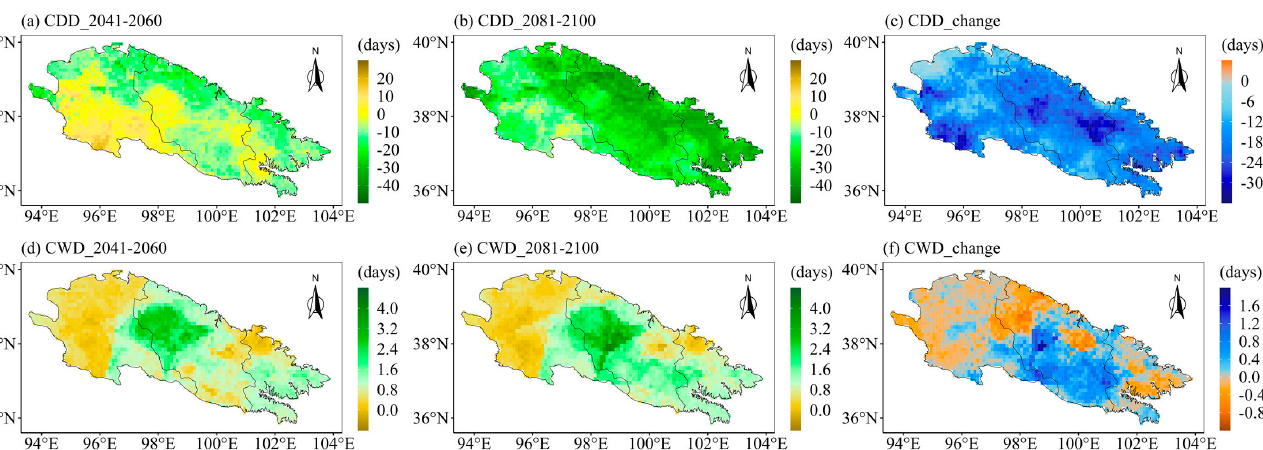
Figure 12. ( left ) The changes of extreme precipitation indices in the middle of the 21st century as compared to the base period, ( middle ) the changes of extreme precipitation indices at the end of the 21st century as compared to the base period, and ( right ) the changes of extreme precipitation indices at the end of the 21st century as compared to the middle of the 21st century. Spatial distri- bution over the Qilian Mountains under SSP585: ( a – c ) CDD, ( d – f ) CWD, ( g – i ) R10mm, and ( j – l ) R95p. Note that the future change is represented by the ensemble of the corrected CMIP6 models. 4.3. Inter-Annual Variations of the Future Extreme Precipitation Indices The Qilian Mountains are the source of many inland river basins in western China, such as the Heihe basin, Shiyanghe basin, Shulehe basin, etc. The inter-annual fluctuation of the extreme precipitation indices over the Qilian Mountains in the 21st century has a direct impact on the downstream runoff change and annual runoff. Therefore, it is very important to project the future inter-annual changes in the extreme precipitation indices over the Qilian Mountains. In order to have an intuitive understanding of the inter-annual changes of the extreme precipitation indices in the Qilian Mountains under different SSPs, the historical and future trends of the eight extreme precipitation indices have been illus- trated in Figure 14. We have first calculated the averages of the extreme precipitation in- dices at all grid points in the Qilian Mountains and have presented their inter-annual changes. It can be seen from Figure 14a that the inter-annual variation in the drought in- dex is strongly volatile both in the historical period and in the future. Additionally, the CDD is likely to follow a fluctuating decrease trend in the 21st century. The remaining seven extreme precipitation indices show a fluctuating upward trend under different SSPs